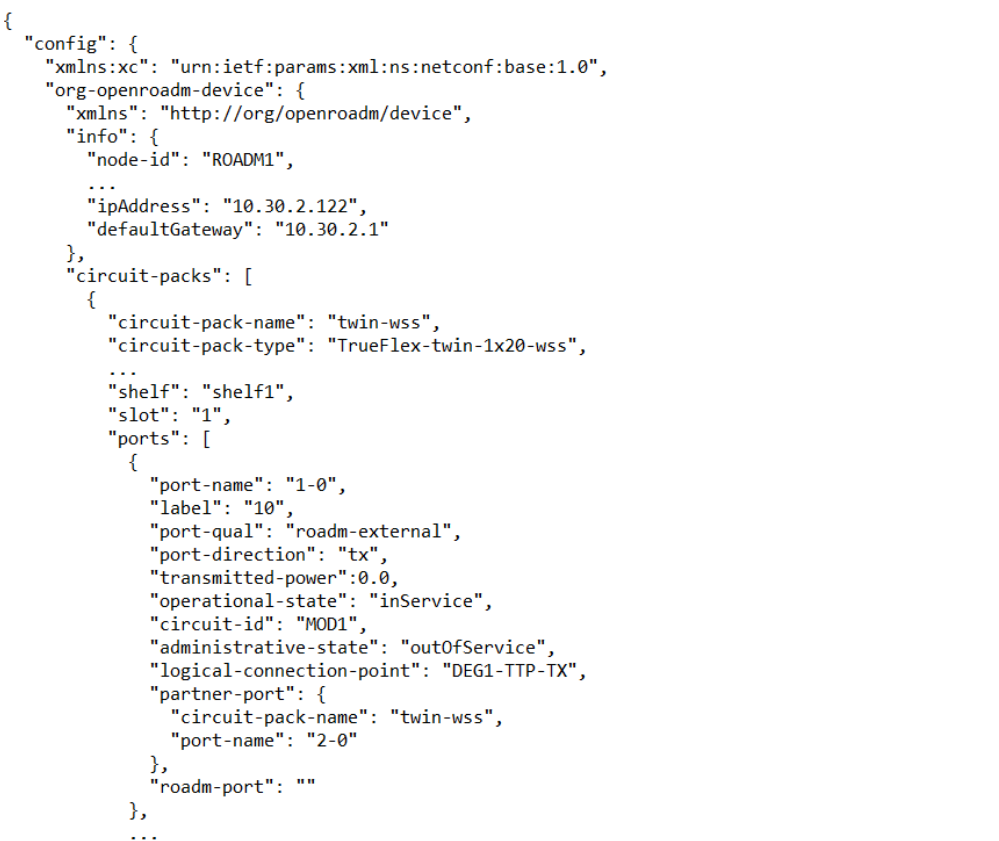
Figure 4. A piece of JSON message representing a model of an ROADM